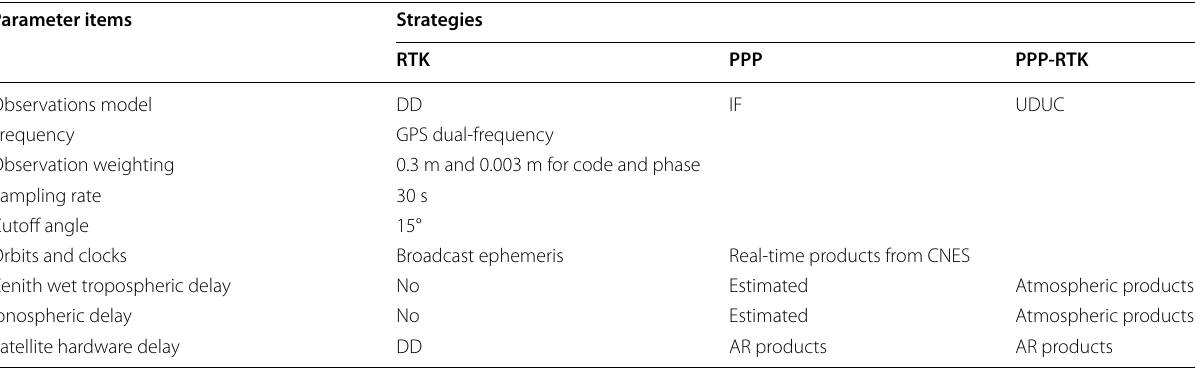
Table 3 Parameter strategies for three techniques